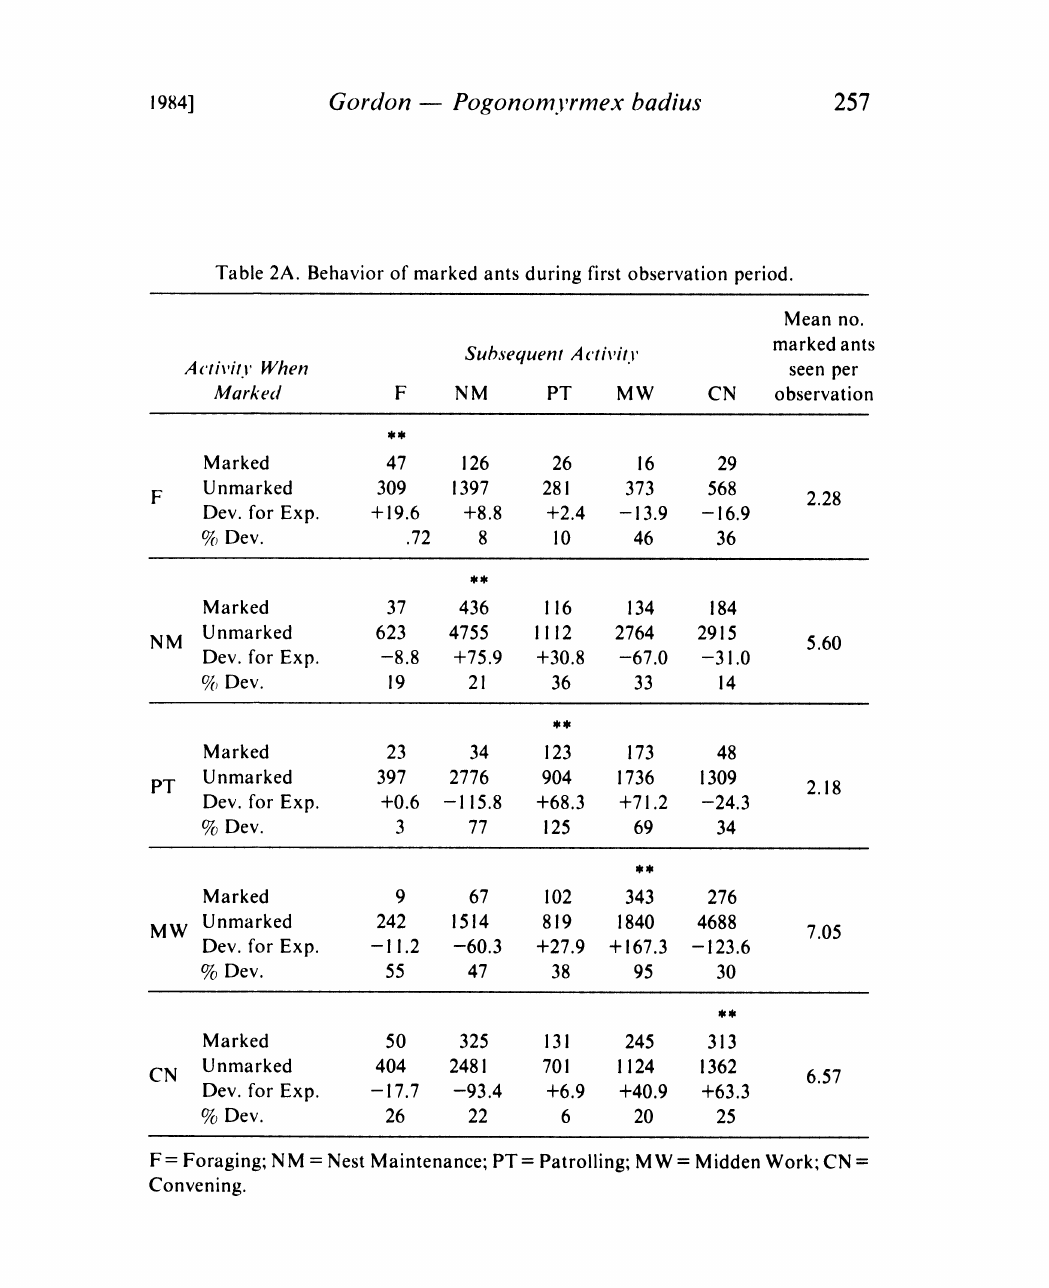
Table 2A. Behavior of marked ants during first observation